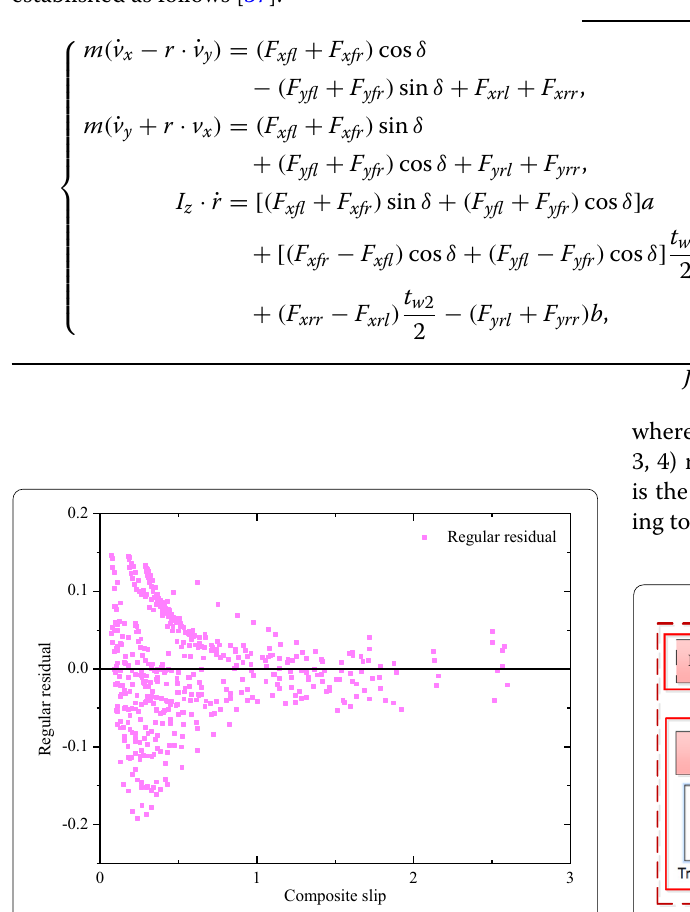
Figure 4 Hierarchical control